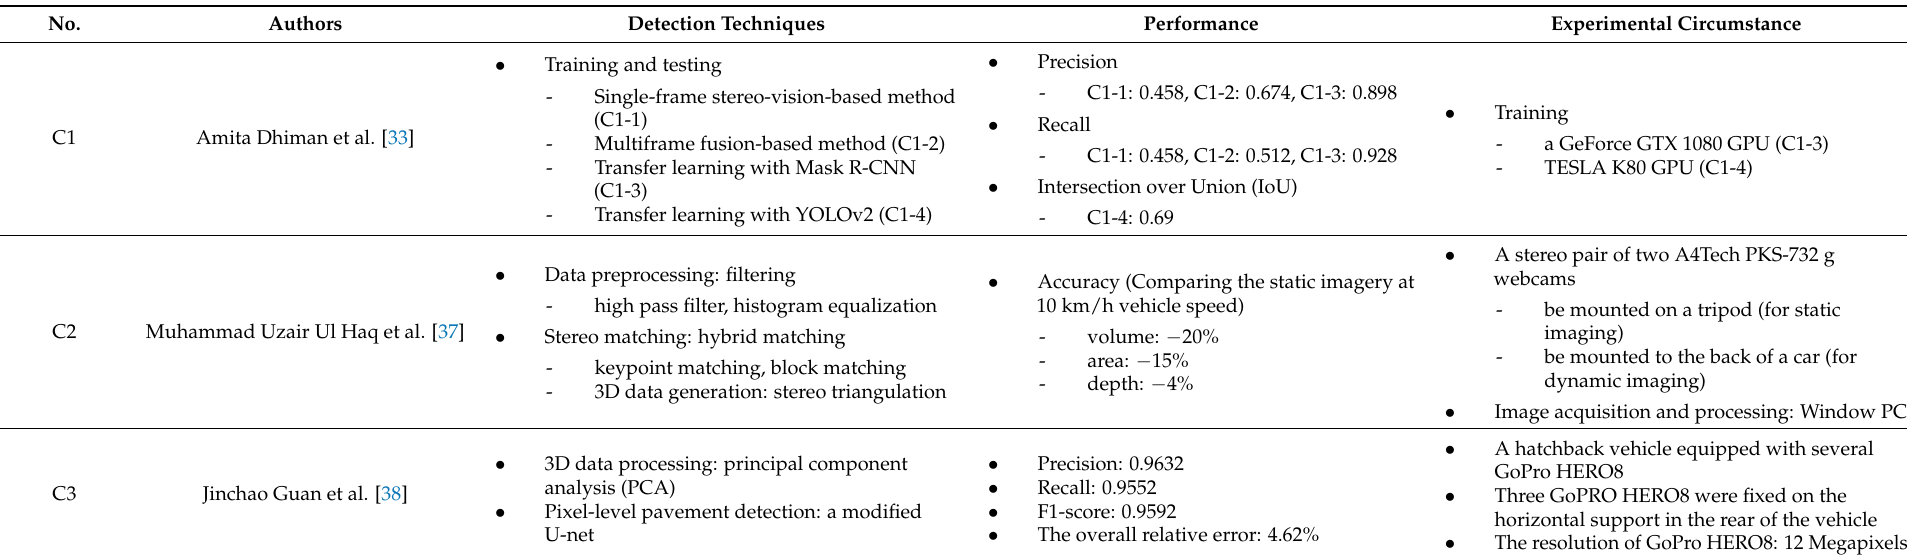
Table 4. Detection techniques and characteristics of 3D reconstruction-based pothole-detection